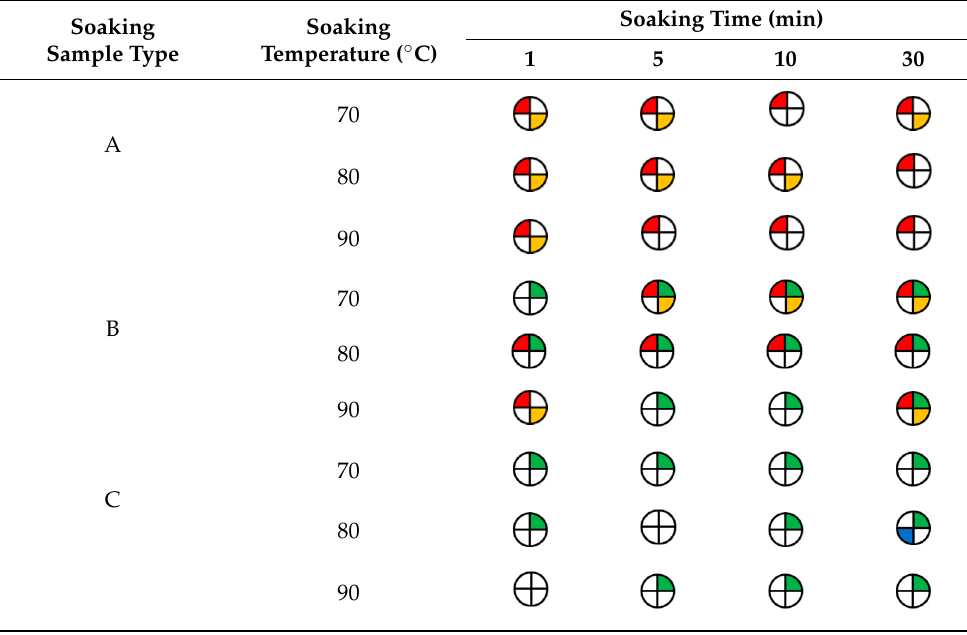
Table 1. Results of simultaneous identification of various MPs released from different filter bags soaked under different conditions.